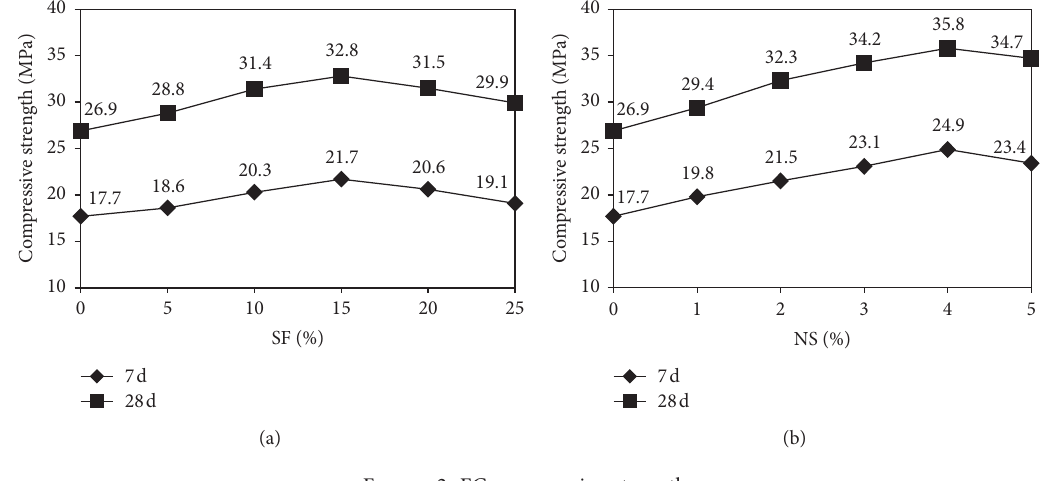
Figure 2: FC compressive strength.